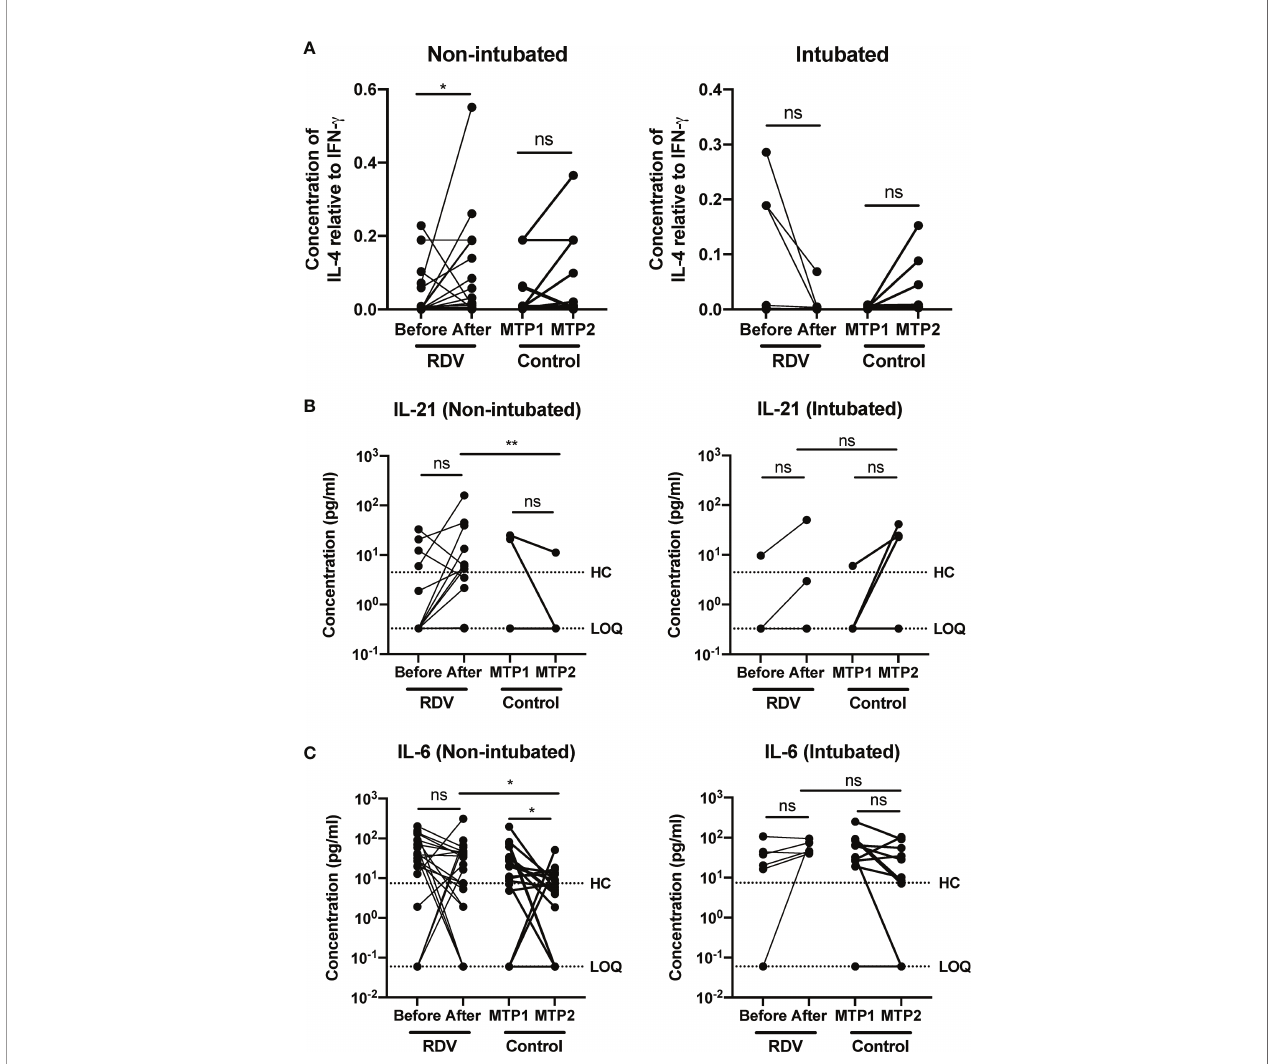
FIGURE 3 | COVID-19 patients responding to remdesivir (RDV) treatment show an increase in T h 2 to T h 1 cytokine ratio. Immune mediator levels in inactivated patient plasma was measured with 45-plex Luminex assay. (A) IL-4 to IFN- g ratio of non-intubated responders and intubated non-responders before and one week after treatment with RDV. Statistical analysis was performed with Wilcoxon matched-pairs signed ranked test (ns, not signi fi cant; * P < 0.05). (B) T h 2-associated immune mediators IL-21 and (C) IL-6 levels in plasma before and after RDV treatment in responders (n = 21, median 9 and 16 days post-illness onset (PIO), respectively) and non-responders (n = 6, median 7 and 13 days PIO, respectively), and matched timepoint 1 and 2 in non-RDV-treated non-intubated (n = 17, median 10 and 16 days PIO, respectively) and intubated (n = 10, median 6 and 12 days post intubation, respectively) controls. Statistical analyses were performed with Wilcoxon matched-pairs signed rank test when comparing between timepoints, and Mann Whitney U test when comparing across groups (ns, not signi fi cant; * P < 0.05; ** P < 0.01). Immune mediator levels for healthy controls (n=23) are indicated by the black dotted line. Patient samples with concentration out of measurement range are presented as the value of Limit of Quanti fi cation (LOQ). ns, not signi fi